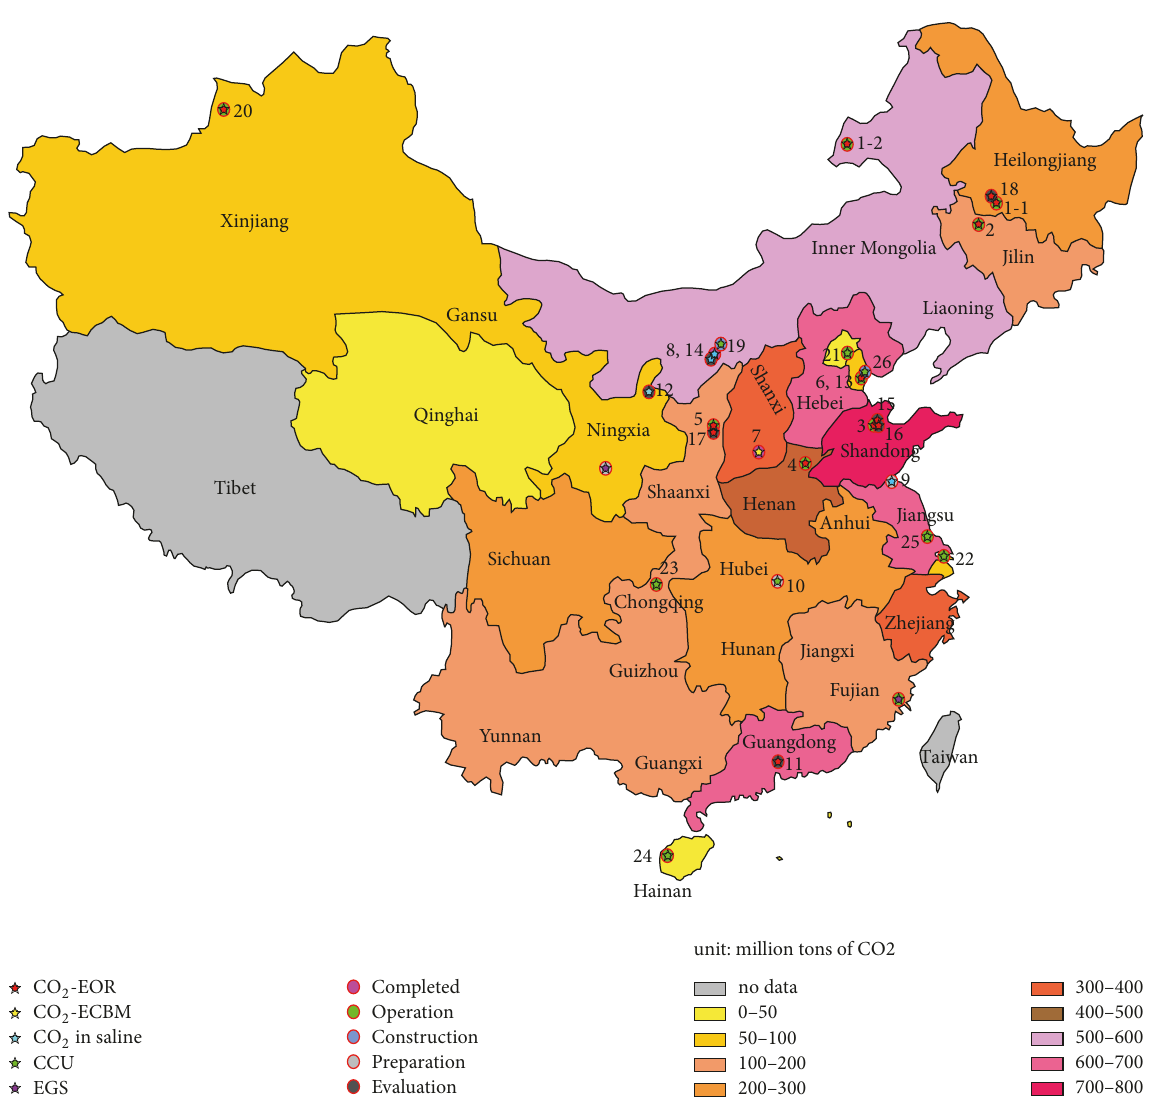
districts of Jinbian and Wuqi, with a total of 90 kilotons CO 2